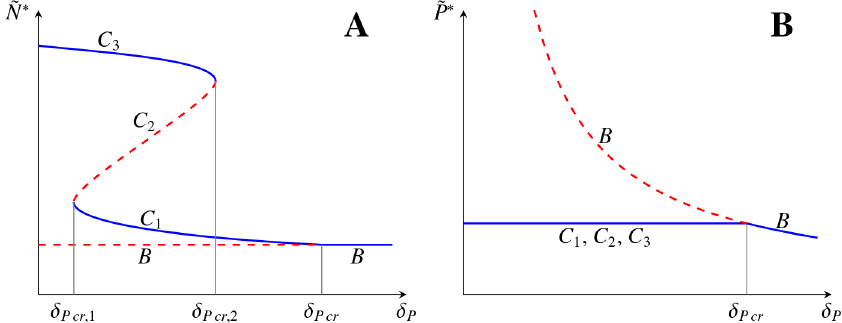
Fig 3. Bifurcation diagram showing coexistence of different tumour morphologies depending on protein degradation rate. Scheme showing a possible bifurcation diagram for the systems (13) – (15) for the tumour cell density N * (A) and the protein density P * (B) as a function of δ P . In the interval δ Pcr ,1 < δ P < δ Pcr ,2 (for more details see Proposition B in S1 Text) a coexistence of the stable steady states is observed. Stability is indicated with solid lines (stable solutions) and dashed lines (unstable solutions).